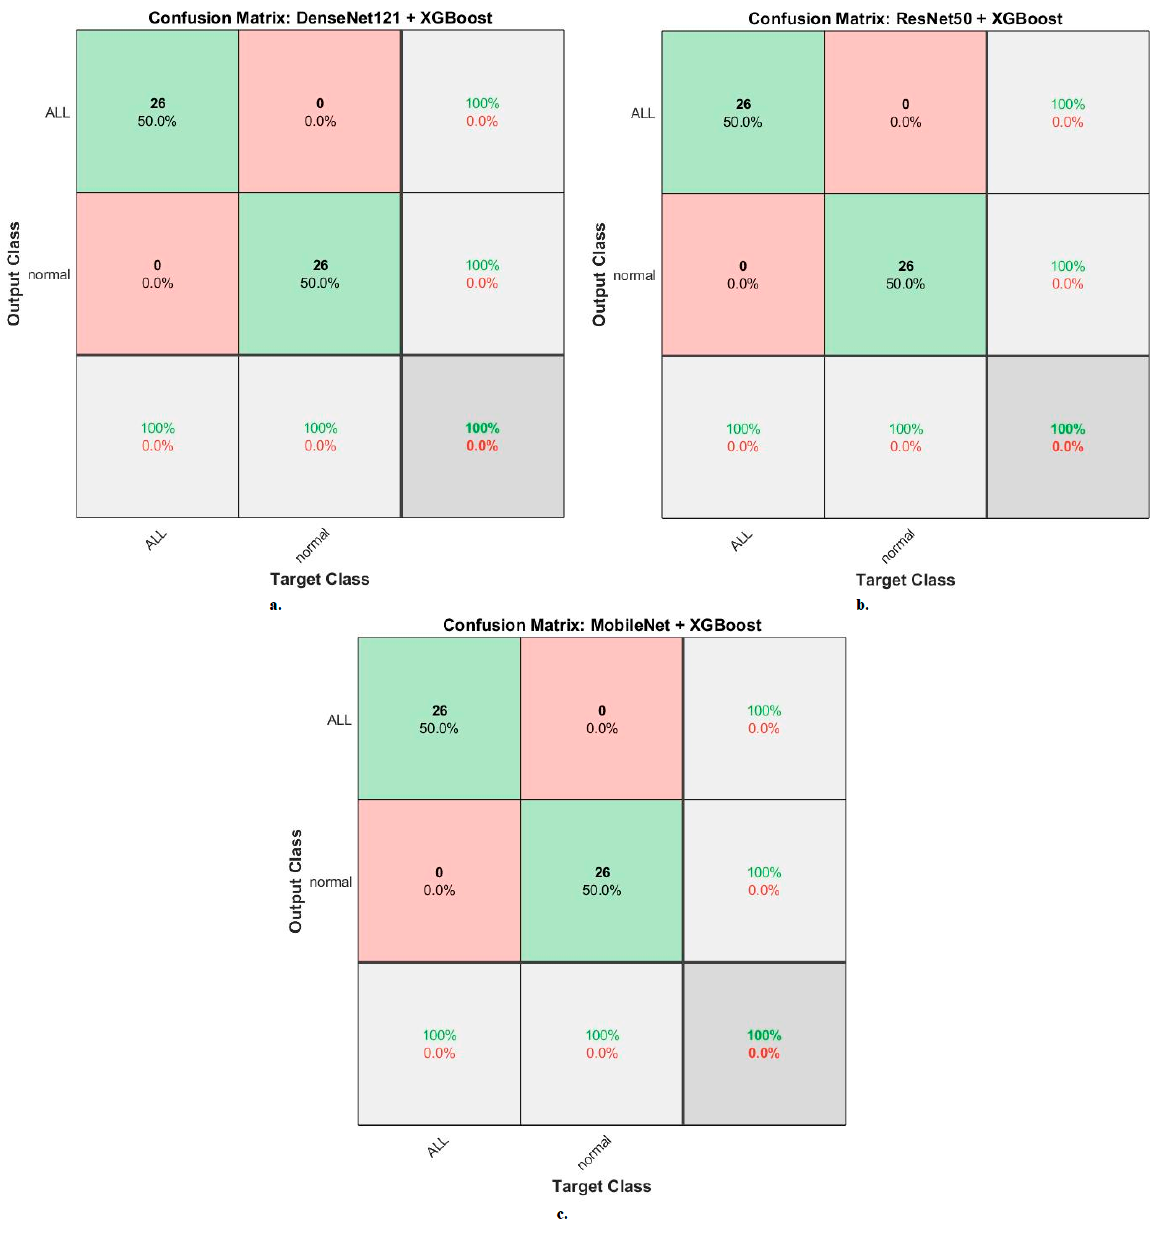
Figure 13. Results of the XGBoost classifier based on the features of the CNN models of the ALL- IDB2 dataset for the diagnosis of acute leukemia confusion matrix of ( a ) DenseNet121-XGBoost. ( b ) ResNet50-XGBoost. ( c ) MobileNet-XGBoost.